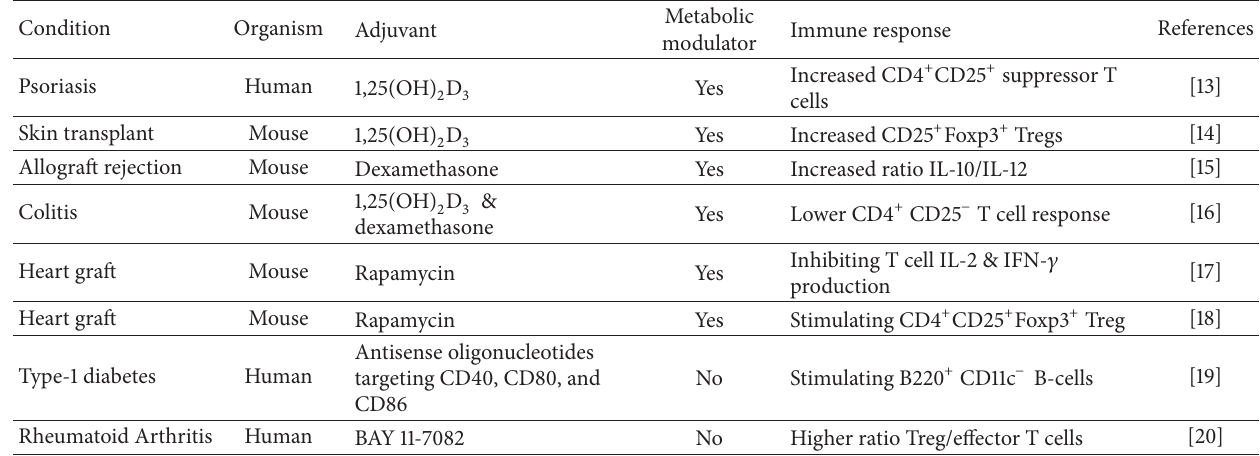
Table 1: Dendritic cell